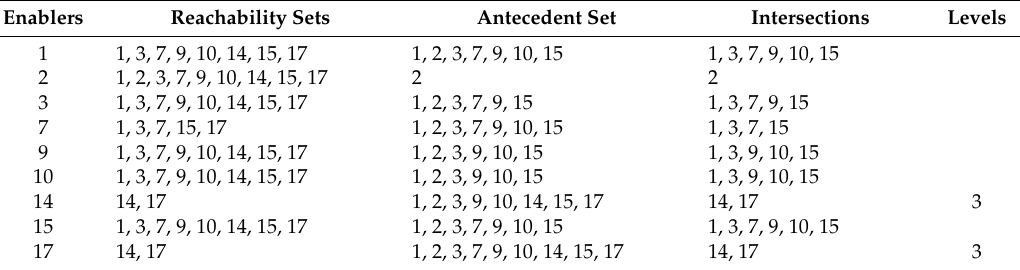
Table 8. Level partitions for enablers—Iteration 3.